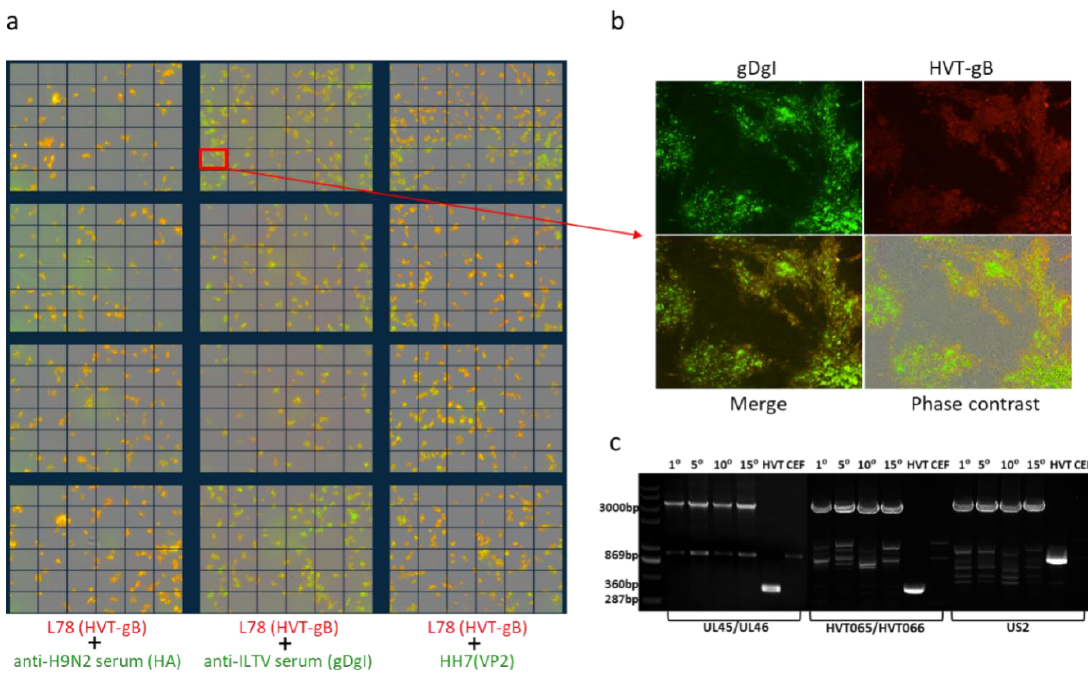
Figure 3. Stability of triple insert recombinant HVT-VP2-gDgI-HA. ( a ) Merged images of double stained HVT-VP2-gDgI-HA infected CEF with anti-HVT-gB MAb antibody L78 (red) and anti-H9N2 chicken serum (green) (left panel), anti-ILTV chicken serum (green) (middle panel) or anti-VP2 MAb HH7 (green) (right panel). Images were taken from 36 separate regions per well and 4 wells per sample in 24-well plates using the IncuCyte. ( b ) The marked region of the merged images of gDgI and HVT-gB staining in (a) is shown enlarged with gDgI staining (green, top left), HVT-gB staining (top-right), the merged image under UV light (bottom left) and phase contrast (bottom right). ( c ) PCR to confirm the presence/absence of the VP2 expression cassette at UL45/46 with primers UL45F/UL46R, gDgI at HVT65/66 with primers HVT65F/HVT66R and HA at US2 region with primers US2F/US2R from the recombinant virus HVT-VP2-gDgI-HA at passage 1, 5, 10, and 15 in CEFs (primer sequence shown in Figure 2b). HVT infected and noninfected CEF were included as controls. The absence of a lower band, during amplification, in the recombinant virus during passage indicates that the recombinant virus is stable. The sizes of the fragments are indicated on the left.